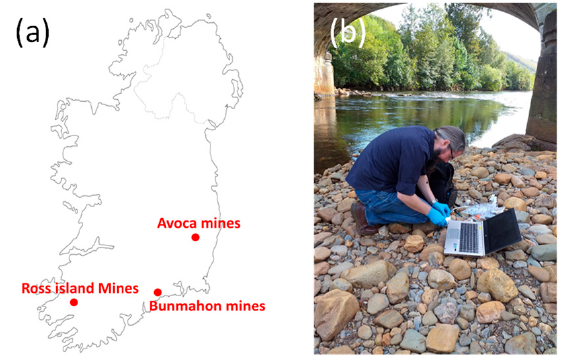
Figure 3. ( a ) Map of Ireland showing the sampling/measurement locations; ( b ) measurement being carried on-site at Avoca river, co Wicklow.